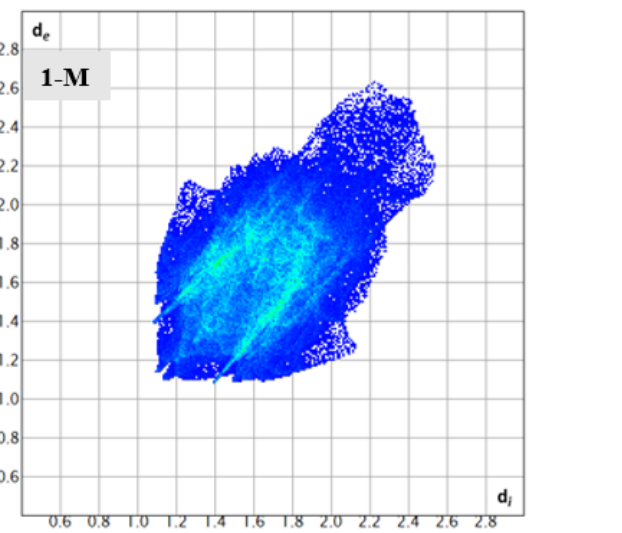
Figure 4. The complete fingerprints for 1-M and 1-O . Surface analysis allows one to draw out the percentages of the individual interactions between atoms within a crystal structure (Figure 6). There were subtle differences in the overall interaction percentages of the two polymorphs. For the monoclinic structure ( 1-M ), there was a lower percentage of H ··· H interactions than for the orthorhombic structure ( 1-O ). There was a slightly lower percentage of H ··· O interactions in 1-M while there was a higher percentage of H ··· N interactions. A higher percentage of C ··· C interactions was exhibited by 1-O , which corresponded to π stacking. Close examination of the mapped d norm surface of 1-O revealed the characteristic hexagonal ‘imprinted’ shape from the symmetry adjacent moiety in the π stacking. The shape index also displayed the characteristic alternating red and blue triangles which corresponded to the